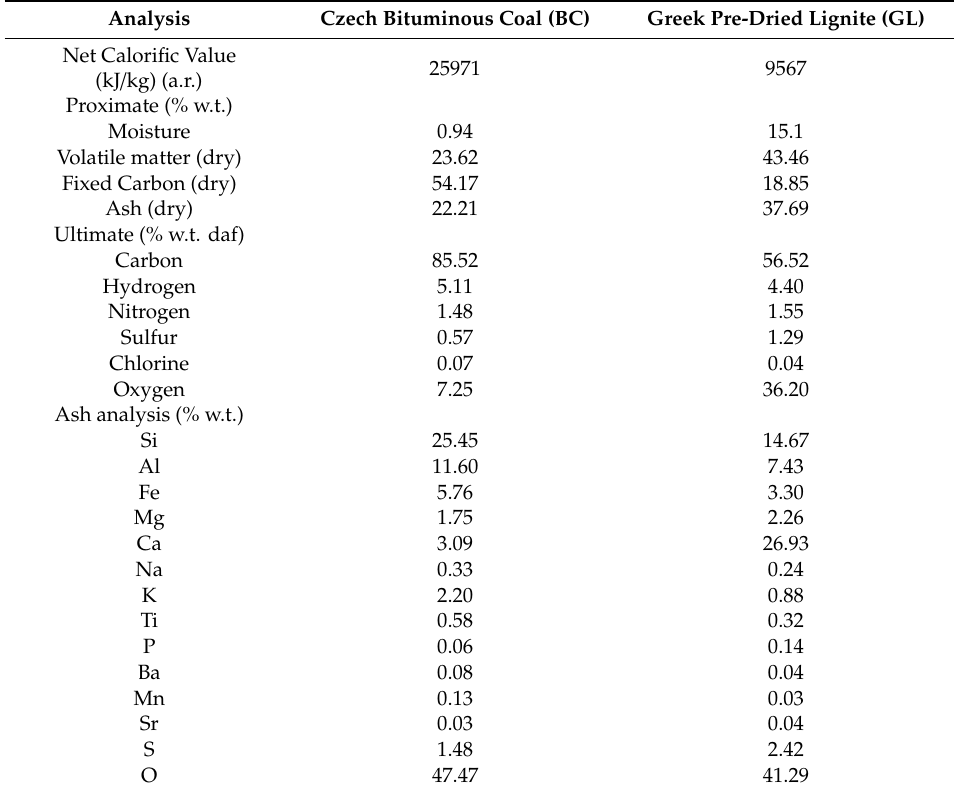
Table 1. Characterization of Czech bituminous coal and Greek pre-dried lignite.